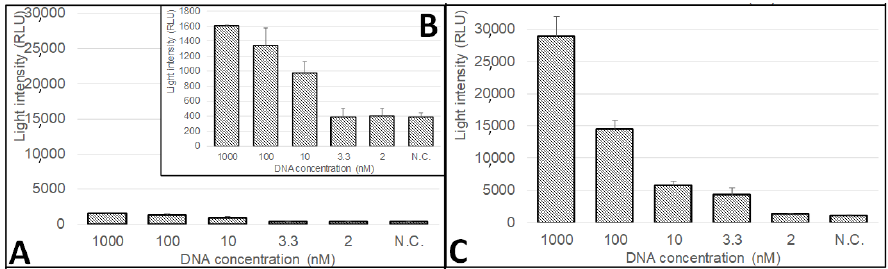
Figure 8. The sensitivity of the CMOS-based biosensor system to Colletotrichum gloeosporioides fungi. The response of the biosensor system to di ff erent concentrations of the quiescent marker of Colletotrichum gloeosporioides , a specific sequence of enoyl-CoA-hydratase / isomerase (Cgl_00014454), before and after integrating the conclusions from the optimization steps of the biosensor procedures. ( A + B ) initial protocol and ( C ) improved protocol. Negative control (N.C.) was used. For both protocols, the modified glass surfaces were immobilized with 20 µ L 1 µ M surface DNA strand, exposed to the target DNA strand in di ff erent concentrations, and later exposed to 20 µ L 1 µ M quiescent-stage reporter DNA